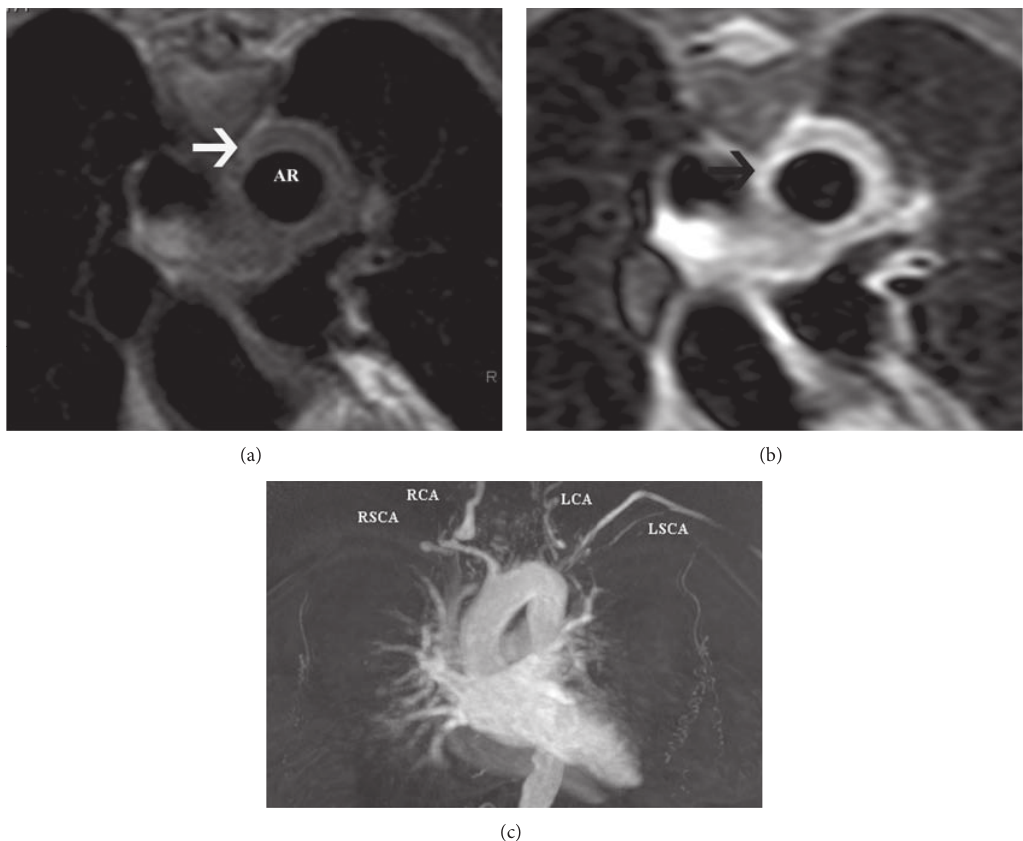
Figure 18: Takayasu arteritis—(a) axial T2-weighted double inversion recovery black blood image in a 31-year-old female patient with Takayasu arteritis shows severe circumferential thickening of the aortic arch (arrows). (b) T2-weighted triple inversion recovery black blood image in the same patient with Takayasu arteritis shows very high signal of the thickened aortic arch (arrows), which is consistent with edema, indicative of active arteritis. (c) 3D contrast enhanced MR angiography images of the arch demonstrate severe stenosis of the left common carotid (LCA), right common carotid artery (RCA), and proximal left subclavian artery (LSCA) with occlusion of the right subclavian artery (RSCA).